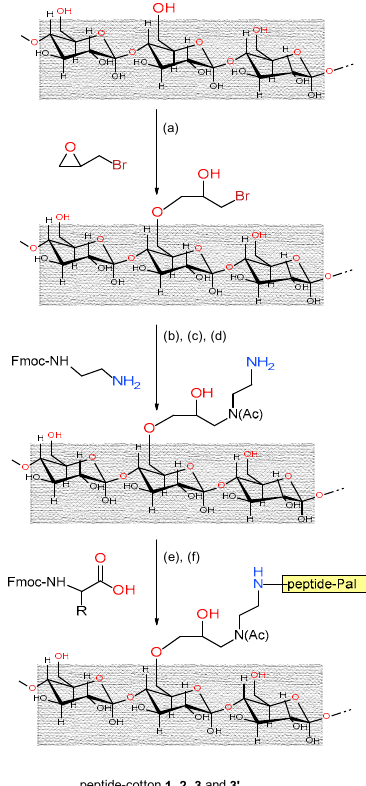
Scheme 1. Synthesis of peptide-cotton samples 1 , 2 , 3 and 3 (cid:48) : ( a ) 60% HClO 4 in N , N